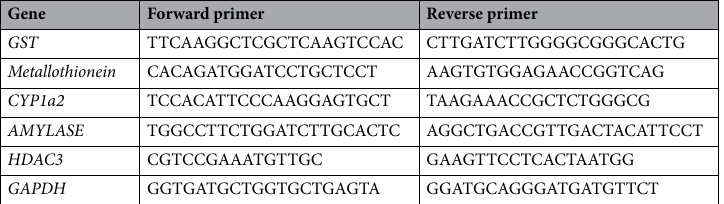
Table 3. Real-time qPCR